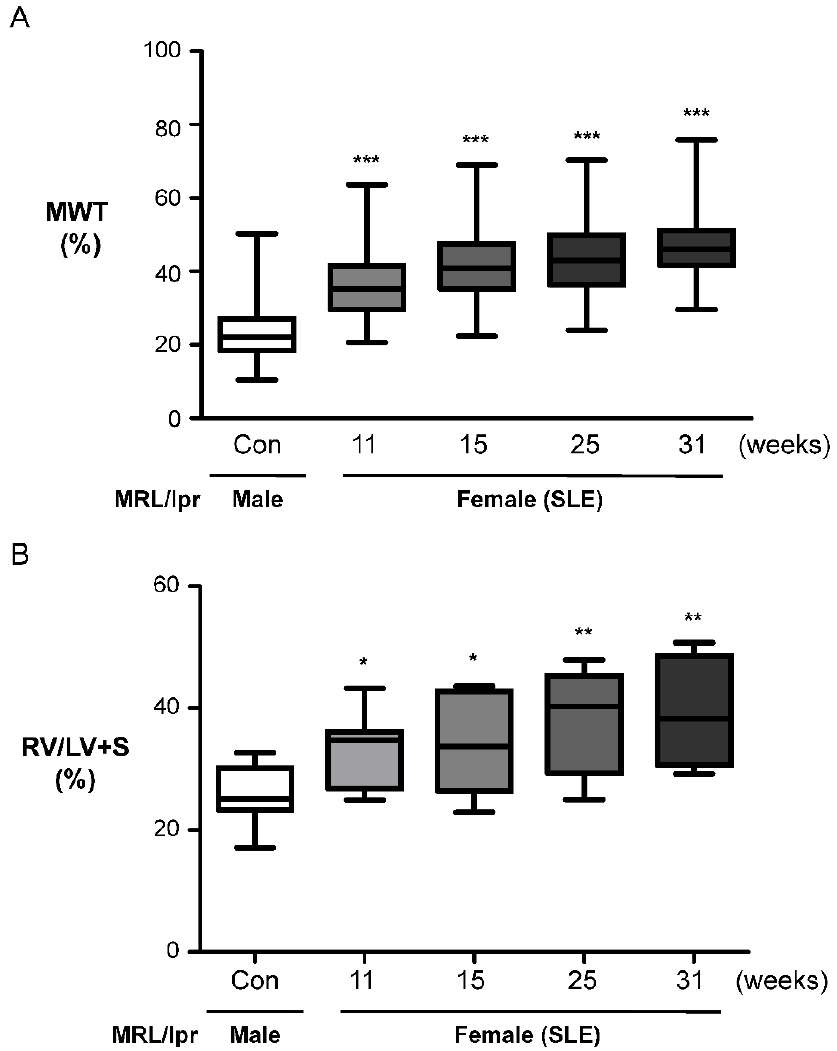
Figure 2. Female MRL/lpr mice showed increased development of pulmonary arterial remodeling and right ventricle hypertrophy. ( A ) Media wall thickness (MWT) values of small PAs (50 – 100 µm) identified by SMA staining. The data are presented as the mean ± SEM ( n = 3 – 5). *** p < 0.001 versus male MRL/lpr mice (Con); one-way ANOVA. ( B ) The ratios of RV to LV plus the septum weight (RV/LV+S) in 5 different groups are shown for male MRL/lpr mice and female MRL/lpr mice. The data are presented as the mean ± SEM ( n = 3 – 5), * p < 0.05 and ** p < 0.01 compared with male MRL/lpr mice. one-way ANOVA.